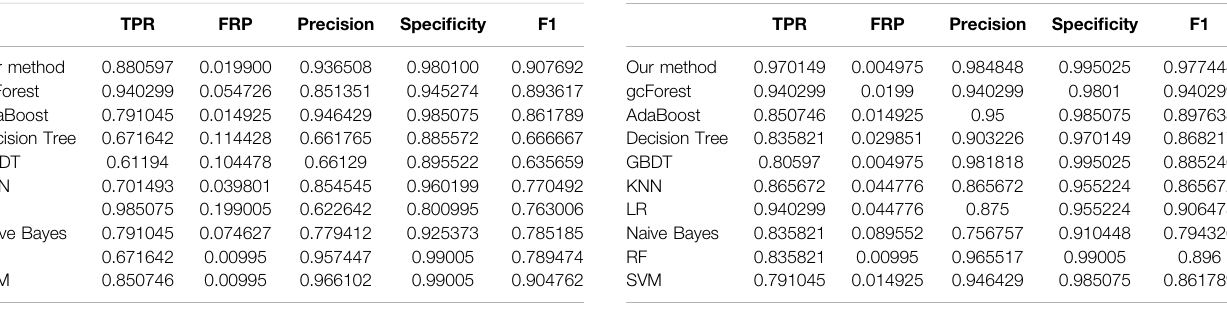
TABLE 4 | Classi fi cation performances of ten methods with 8-cross validation methods.